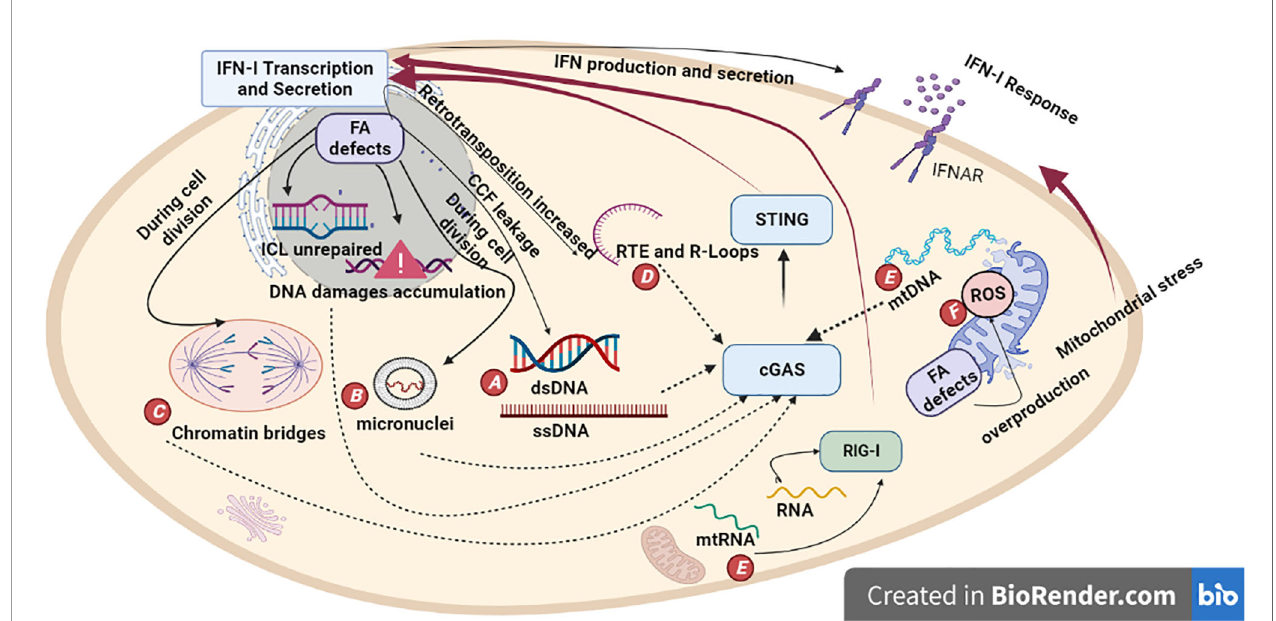
FIGURE 2 | Proposed model depicting how defect in the FA pathway could induce pathological IFN-I production. FA proteins prevent genome instability by repairing DNA damage, repressing retrotransposition and allowing accurate cell division. In addition, FA proteins modulate anti-oxidative response and participate in mitochondria clearance by autophagy and mitophagy processes. Mutations in FA genes or loss of FA proteins contribute to DNA damage accumulation, genome instability, reactive oxygen species (ROS) production and defect in mitochondria ’ s clearance. Under these pathological conditions, many types of self-nucleic acids such as ssDNA and dsDNA (A) , micronuclei (B) chromatin bridges (C) retroelements (RTE) and R-loops (D) , mtDNA/RNA (E) , can activate type-I Interferon (IFN-I). This would occur by cGAS and RIG-I detection of cytosolic DNA and RNA molecules respectively and subsequent production of IFN-I. In addition, elevated levels of ROS might contribute to fuel the production of IFN-I by creating more DNA and mitochondria damage (F)